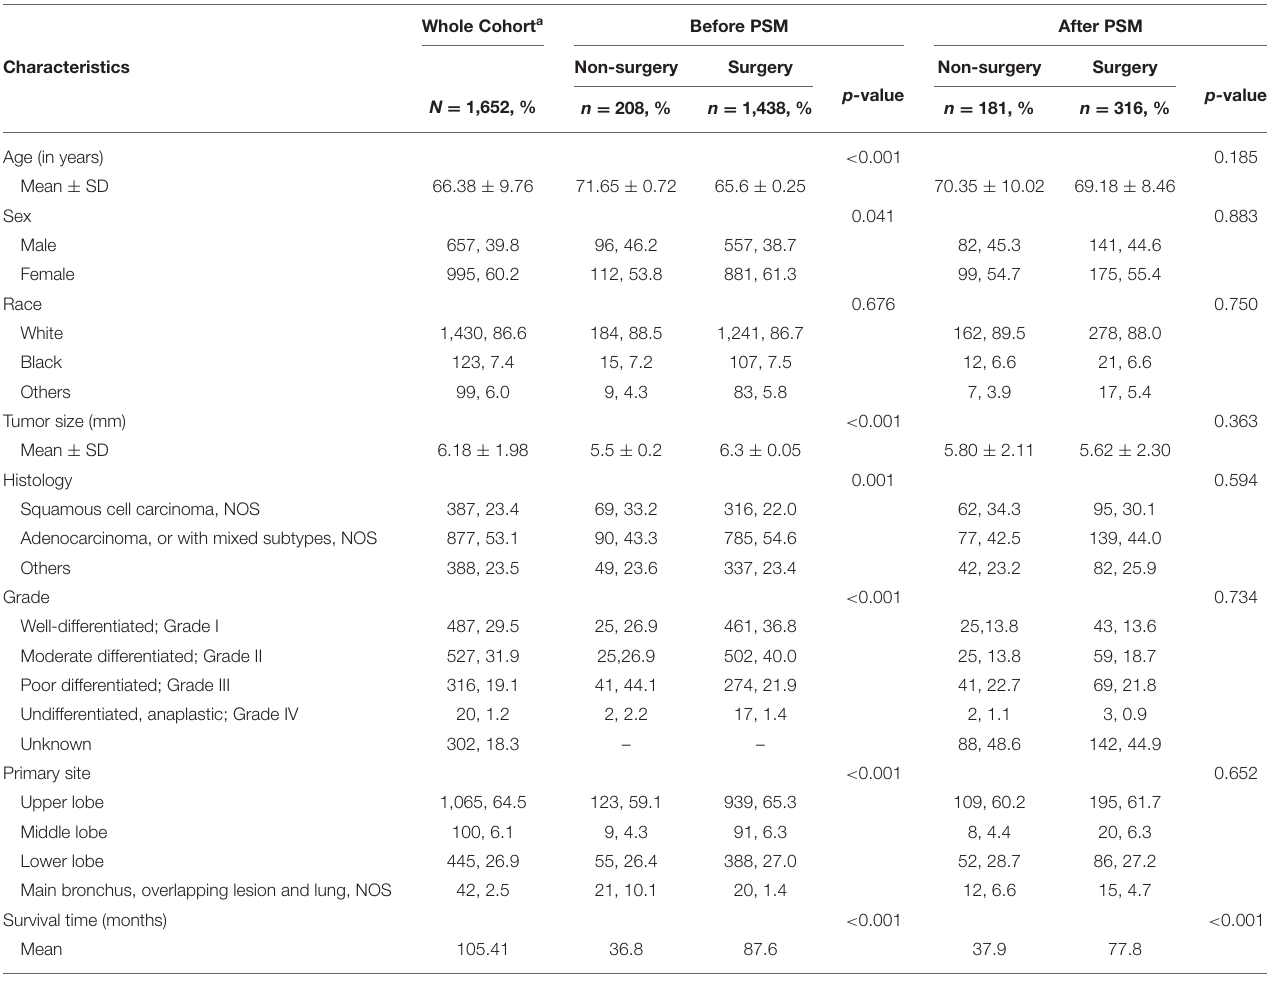
TABLE 1 | Characteristics of NSCLC patients with tumor size ≤